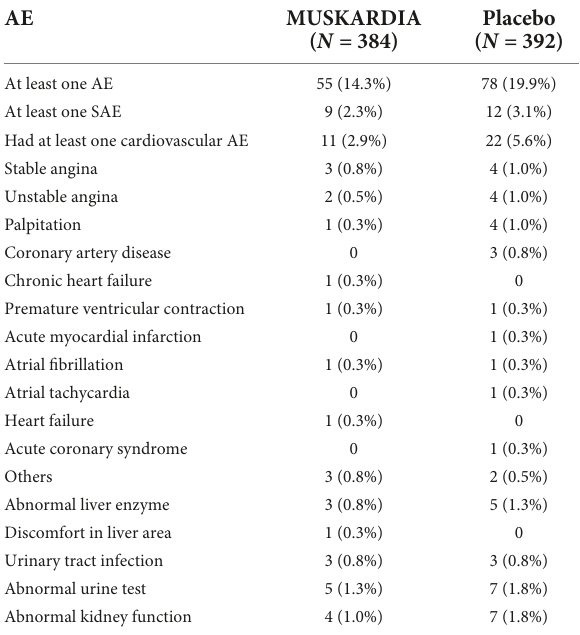
TABLE 4 Adverse events (AEs) and cardiovascular